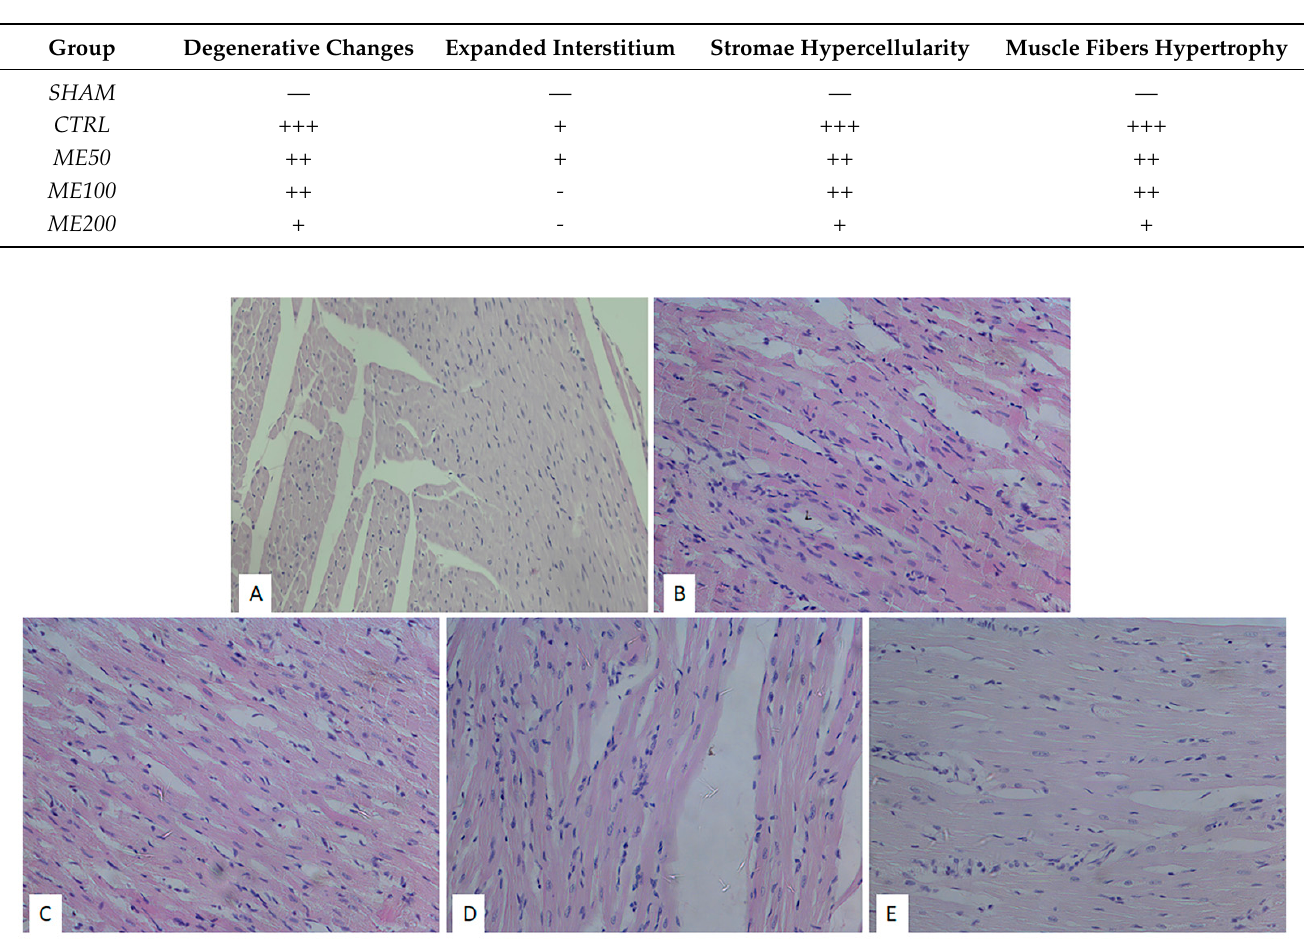
Table 1. Histopathological changes of myocardial tissue depending on the degree, presence, or absence of degenerative changes, expanded interstitium, stromae hypercellularity, and muscle fibers hypertrophy.